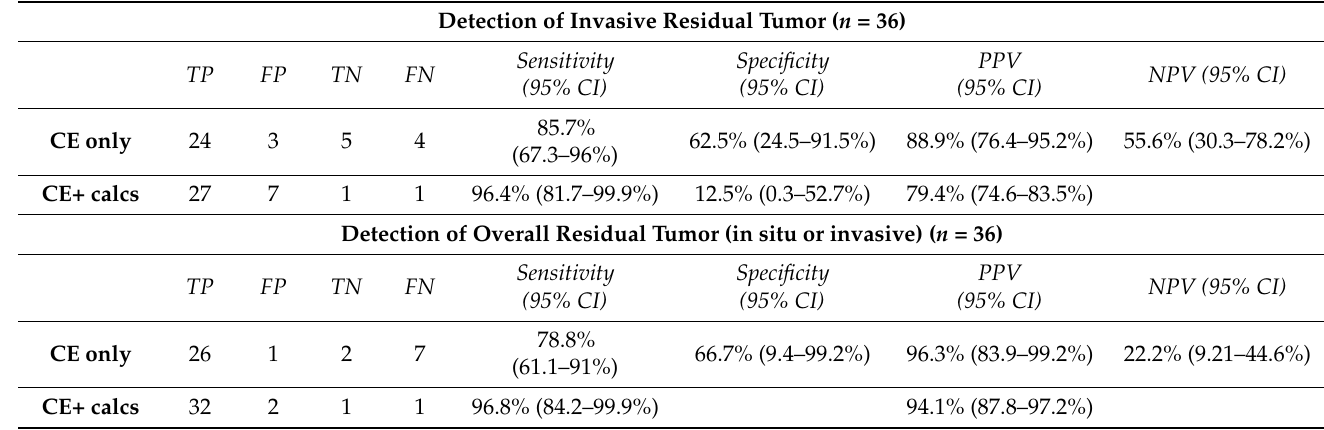
Table 2. Sensitivity, specificity, positive predictive value, and negative predictive value of CEM with respect to pathological reference standard in the detection of invasive residual